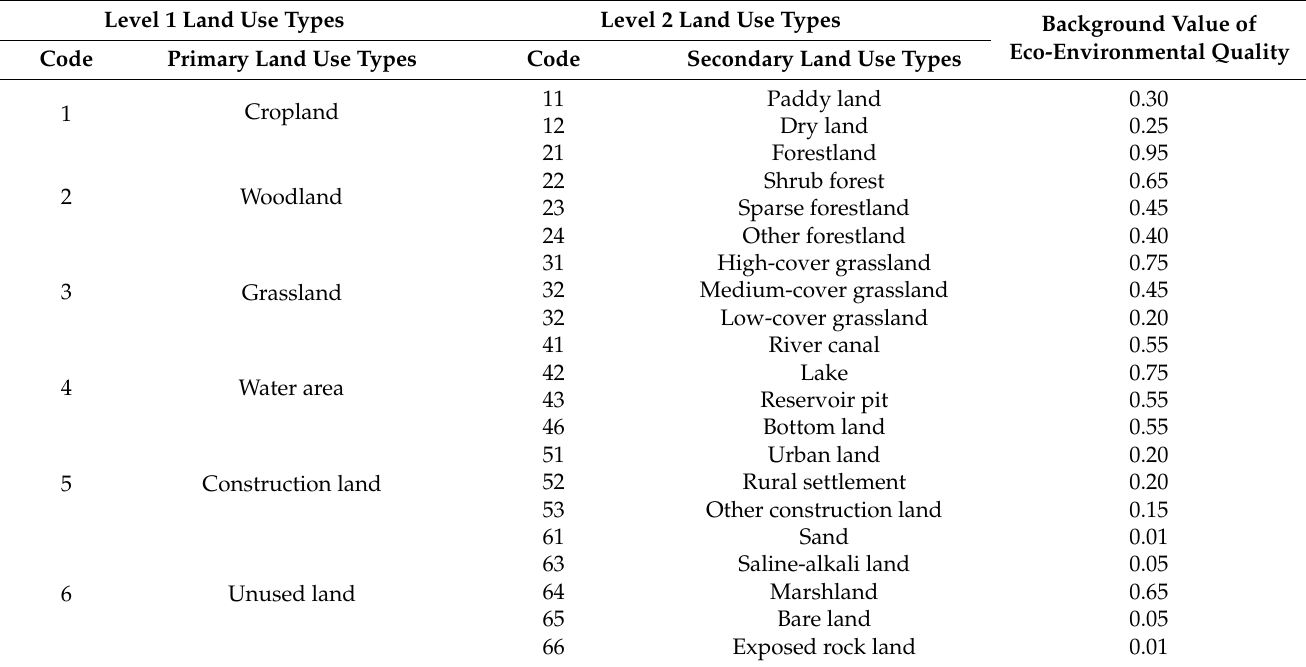
Table 1. Land use classification and eco-environmental